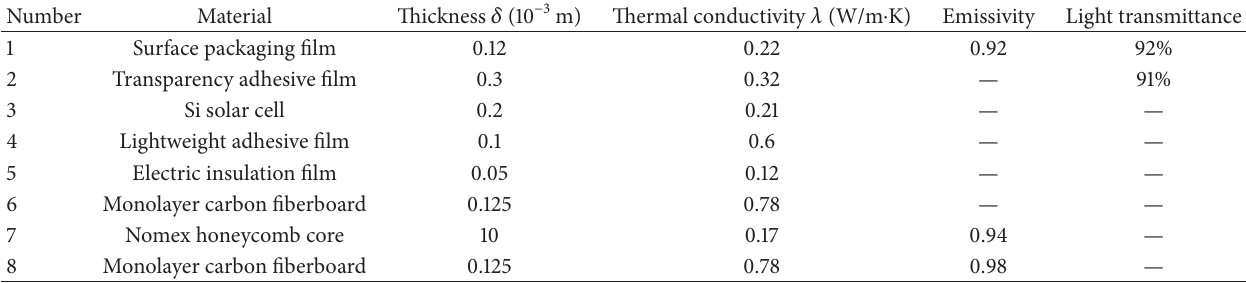
Table 1: Materials physical parameters of lightweight and high-efficiency solar cell